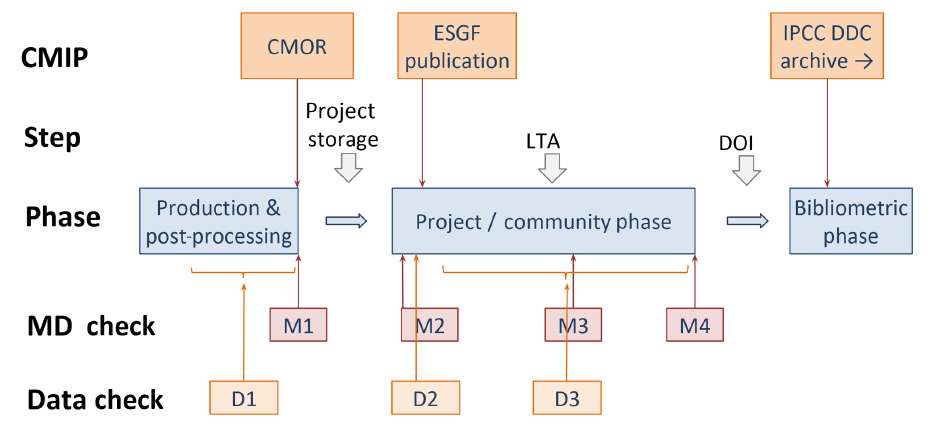
Figure 5. Schematic of the phases of quality assurance, displaying earlier stages in the hands of modelling centres (left), and more formal long-term data curation stages (right). Quality assurance is applied both to the data (D, above) as well as the metadata (M) describing the data. Figure drawn from the WIP’s Quality Assurance position